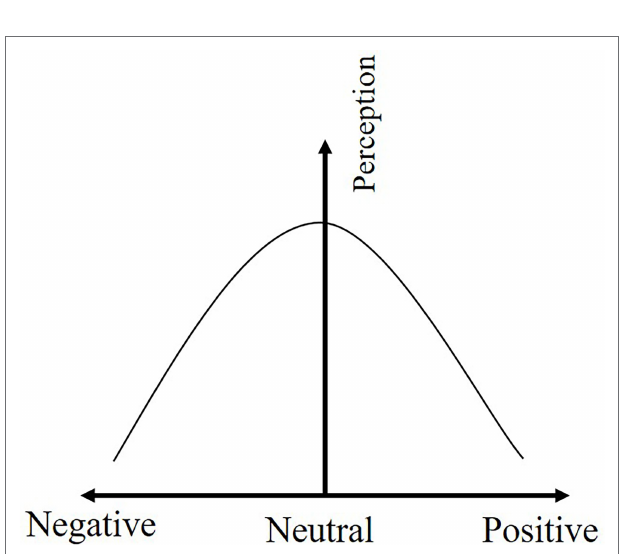
FIGURE 11 | The effect of emotional valence on the perception level of safety